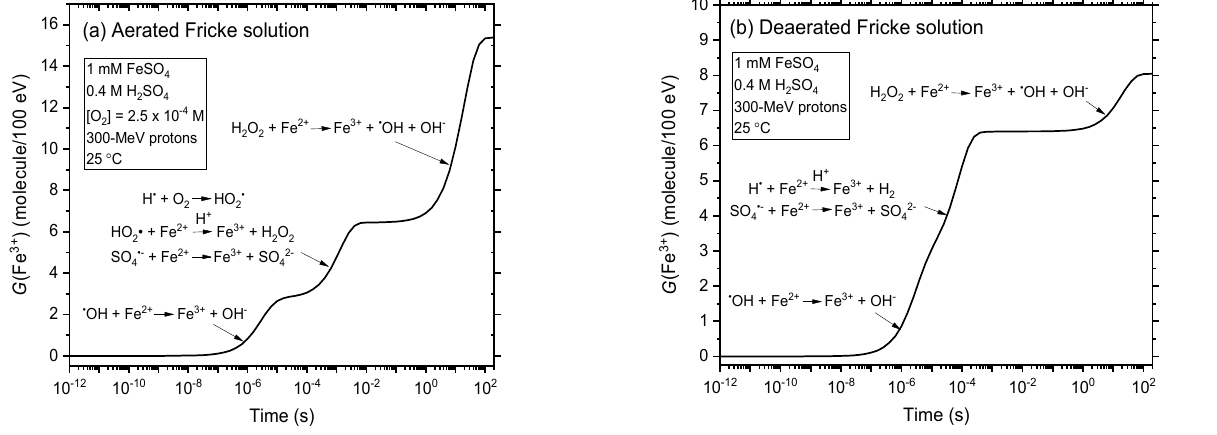
Figure 2. Temporal evolution of G (Fe 3+ ) obtained from our Monte Carlo simulations of the radiolysis of the Fricke solution (1 mM Fe 2+ ions in aqueous 0.4 M H 2 SO 4 ) under aerated (panel ( a )) and deaerated (panel ( b )) conditions, using 300-MeV incident protons at 25 ◦ C, in the interval of ~1 ps–200 s. Data are for N = 1 (i.e., in the absence of dose-rate effects); they mimic the Fricke dosimeter radiolysis by 60 Co γ -rays or fast electrons. Note here that, for solutions of 0.4 M in H 2 SO 4 , a small number of • OH radicals react with HSO 4 − to form the sulfate radical SO 4 •− . Nevertheless, the overall Fe 3+ yield remains the same as that given by Equations (8) and (9), SO 4 •− reacting with Fe 2+ in a similar way as • OH: SO 4 •− + Fe 2+ → Fe 3+ + SO 42 − ( k = 9.9 × 10 8 M − 1 s − 1 )